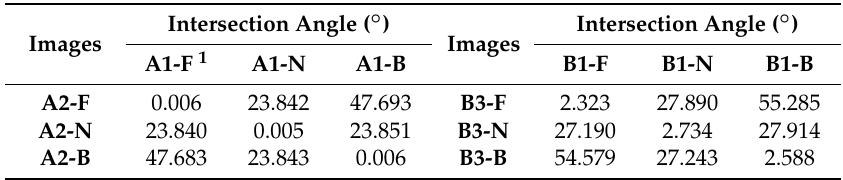
Table 1. The intersection angles of overlapped